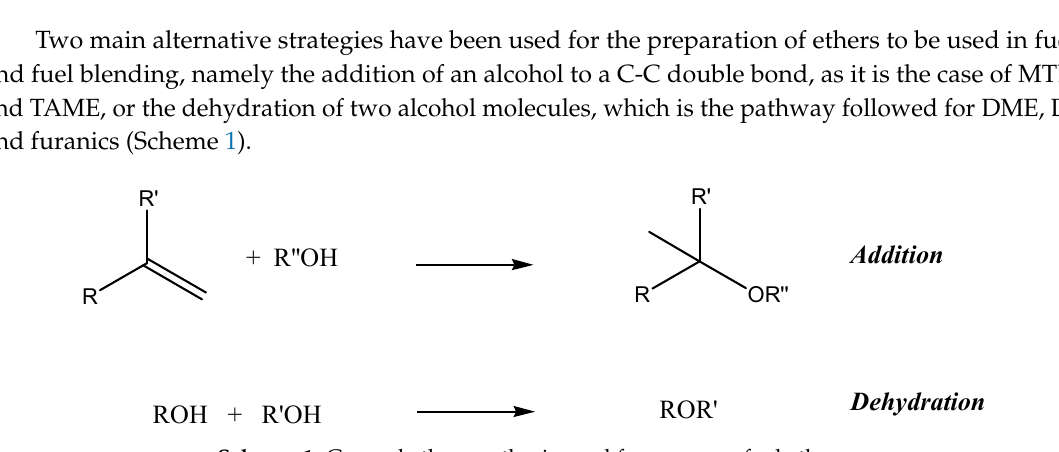
Scheme 1. General ether synthesis used for common fuel ethers.